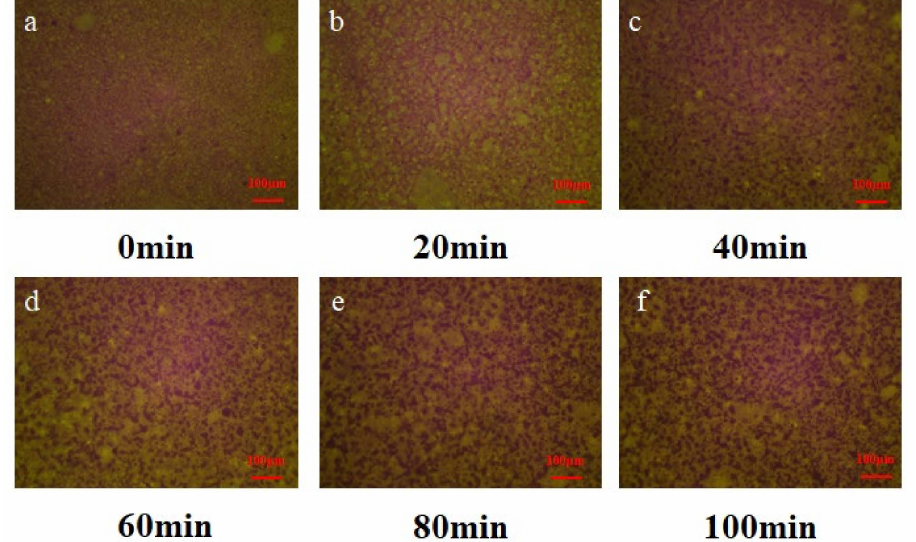
Figure 10. Microstructure of extraction oil/epoxy emulsified asphalt at different curing times. (( a ) 0 min, ( b ) 20 min, ( c ) 40 min, ( d ) 60 min, ( e ) 80 min, ( f ) 100